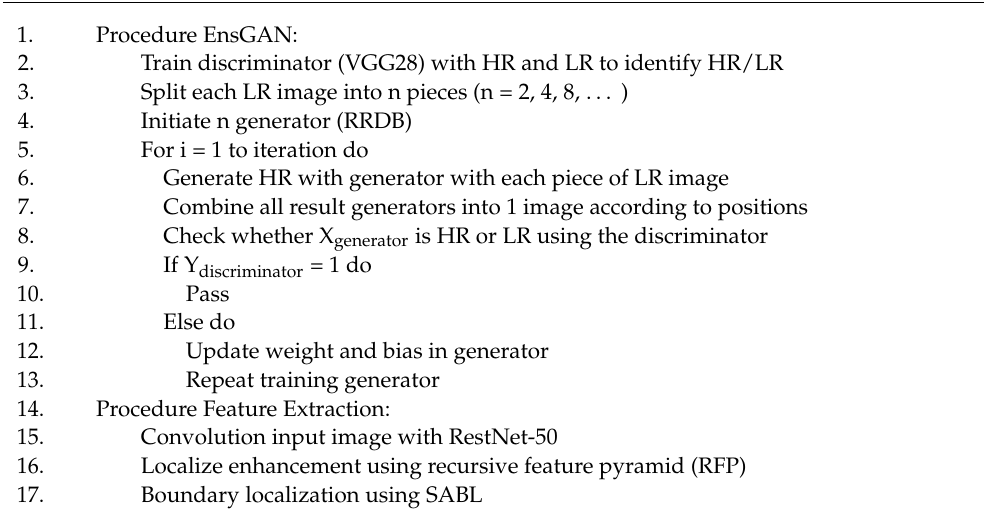
Algorithm 1 Algorithm of the proposed